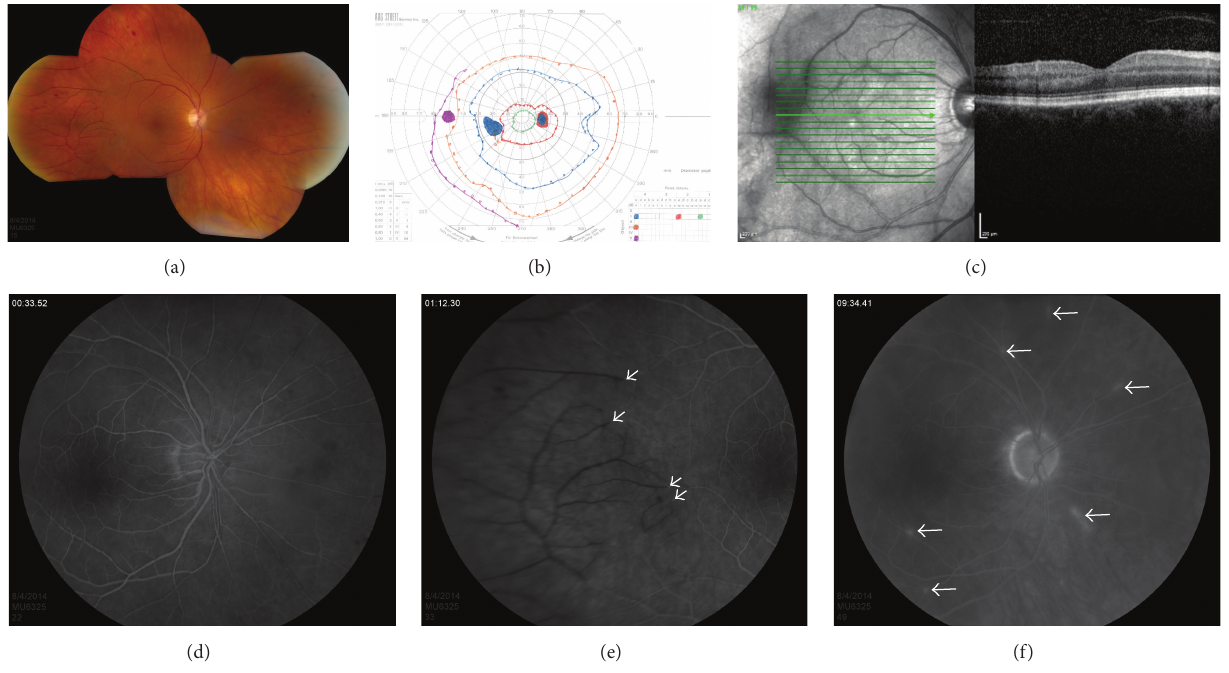
Figure 1: Presentation of ischemic hemorrhagic retinal vasculitis after cataract surgery with intracameral vancomycin. Color fundus montage photograph displays attenuated retinal vessels with arteriolar nonperfusion and distal branch retinal artery occlusions (a). Goldmann visual field shows enlargement of the blind spot to the I4e isopter, paracentral scotoma to the I4e isopter, and central constriction of the I1e and I2e isopters (b). Optical coherence tomography illustrates adequate representation of all retinal layers (c). Fluorescein angiography with delayed retinal and choroidal filling in the mid frame (d). Late frames show numerous peripheral branch retinal artery occlusions (e) and scattered areas of vessel wall hyperfluorescence (f). The left eye was normal with no abnormal findings except moderate nuclear